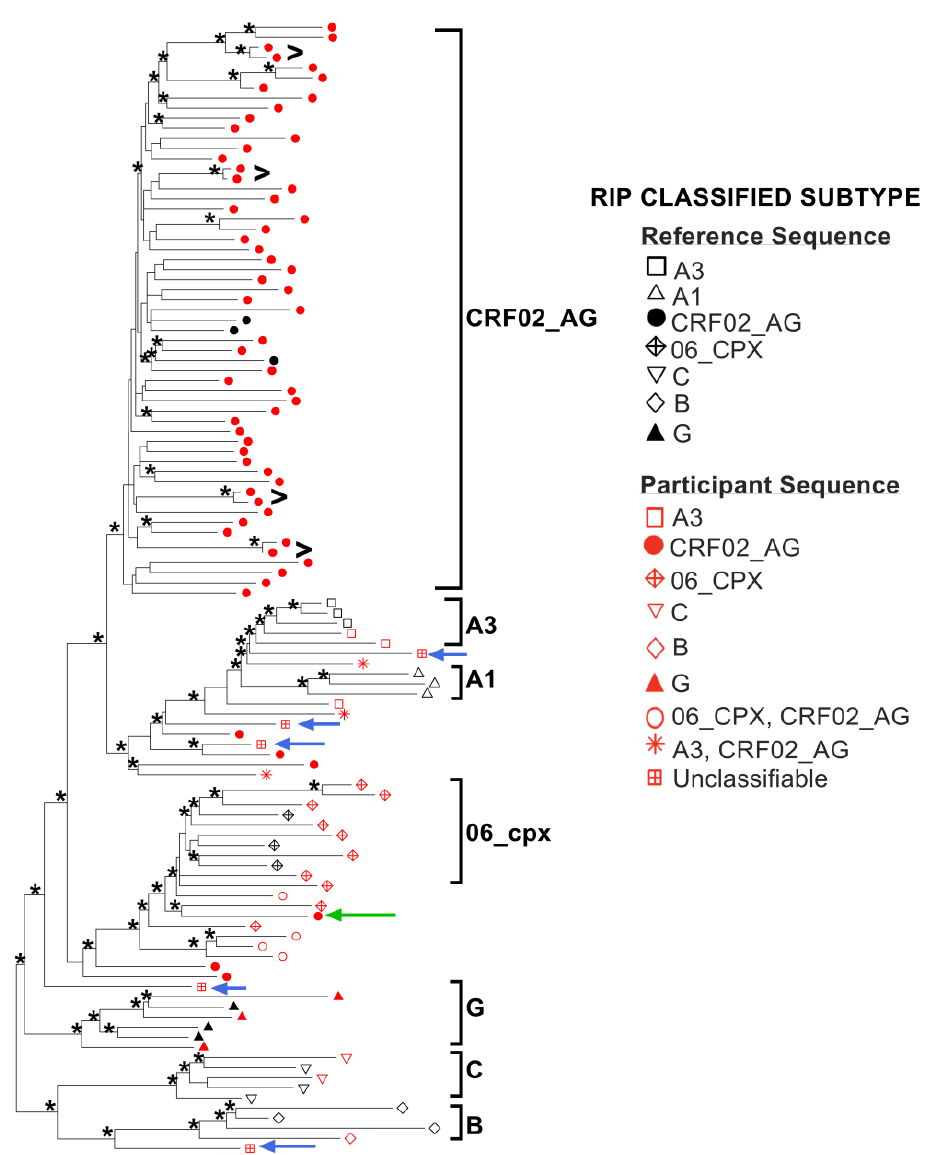
Figure 4. Maximum likelihood protease-RT phylogeny. The tree was inferred from 91 protease-RT sequences from participants (red symbols) and 21 reference sequences representative of cohort diversity (3 each for 7 subtypes; black symbols). Phylogeny is rooted at midpoint. Blue arrows denote sequences with unclassifiable subtypes by RIP, shown in the same order from top to bottom as Figure 3. Black “>“ symbols show known epidemiologically linked pairs. Green arrow shows the sequence in Figure 2C. Scale in estimated nucleotide substitutions per site. Asterisks (*) indicate branches with approximate bootstrap values >70.